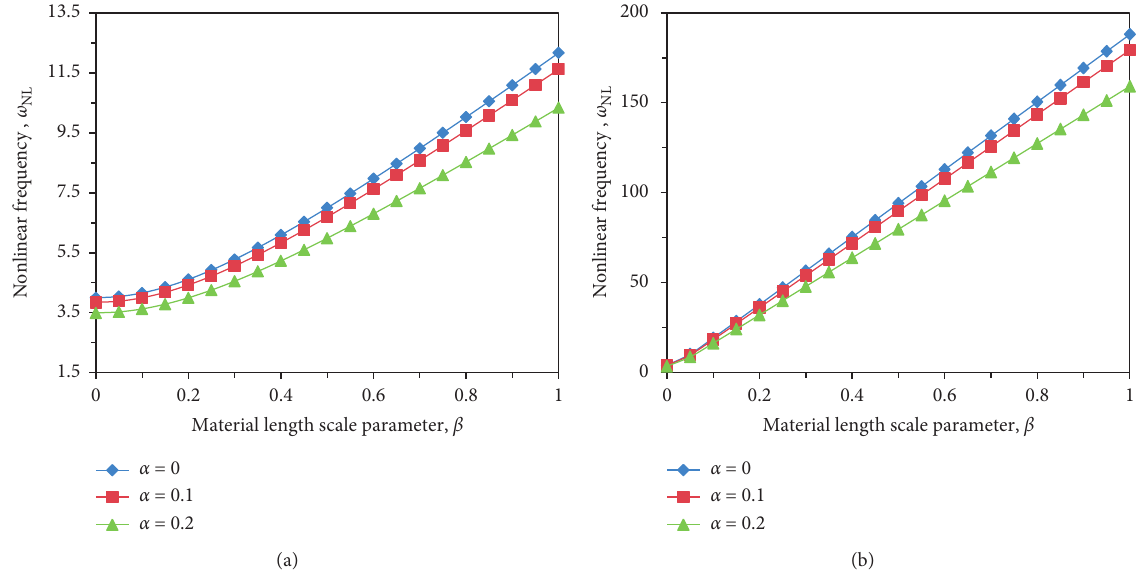
Figure 3: The variation of the frequency ratios of the FG nanobeams to the nonlocal parameter for k � 5, L / h � 15, and V without thickness effect; (b) with thickness effect.